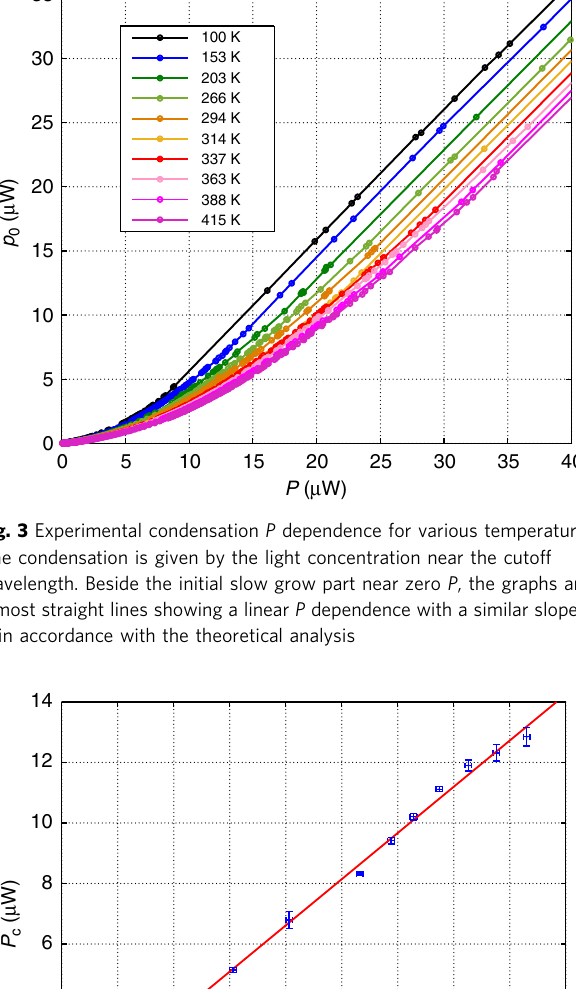
Fig. 4 Threshold power P c dependence on temperature T . It is obtained by the intersection with the P- axis of the linear parts fi t in Fig. 3. The graph gives an almost linear dependence in accordance with the theoretical result of P = aT . The slope in the experiment is (0.031 ± 0.003) μ W/K, close to the theoretical value a ≈ 0.034 μ W/K without any adjustable parameter. The error bars result from uncertainty in the temperature measurements of the fi ber core, as well as s.d. in the fi tting of the linear parts of the